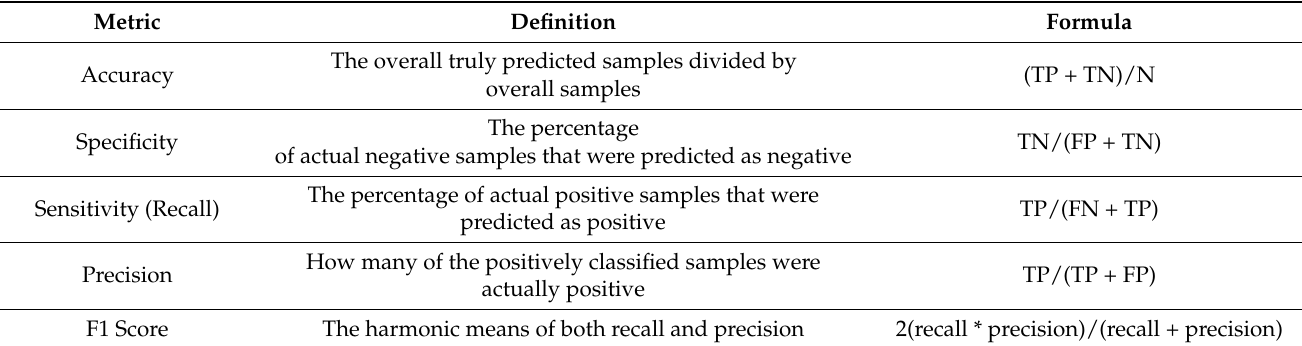
Table 2. Evaluation